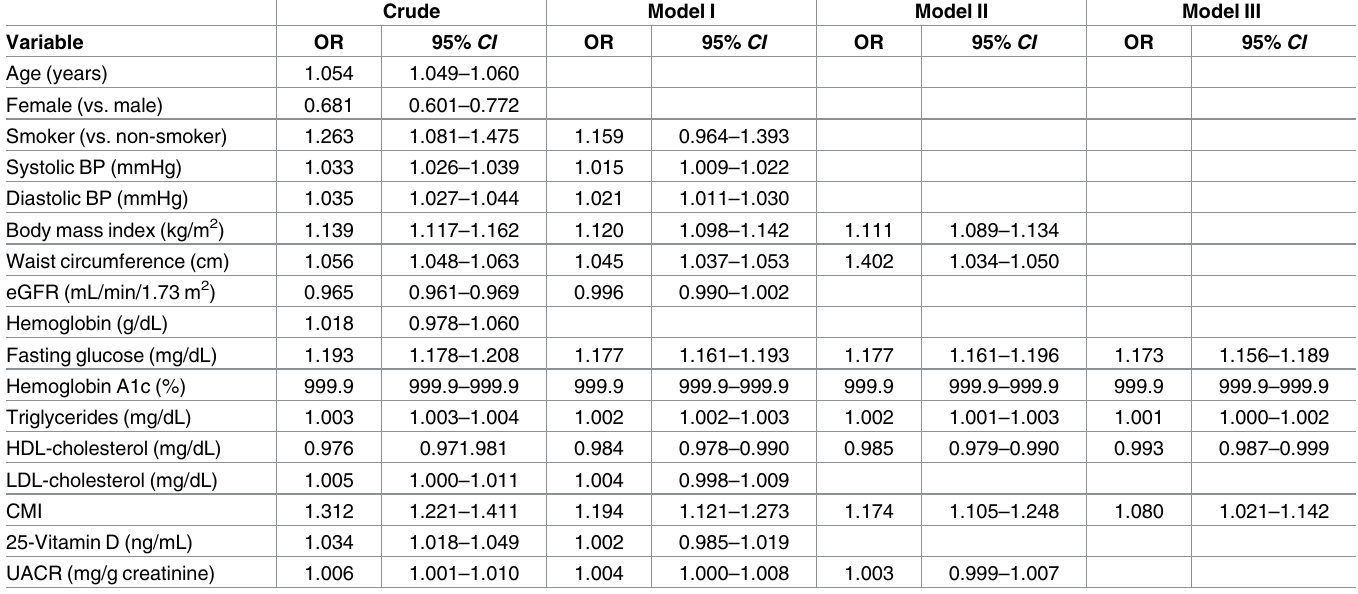
Table 2. Multivariable logistic regression for prediabetes *